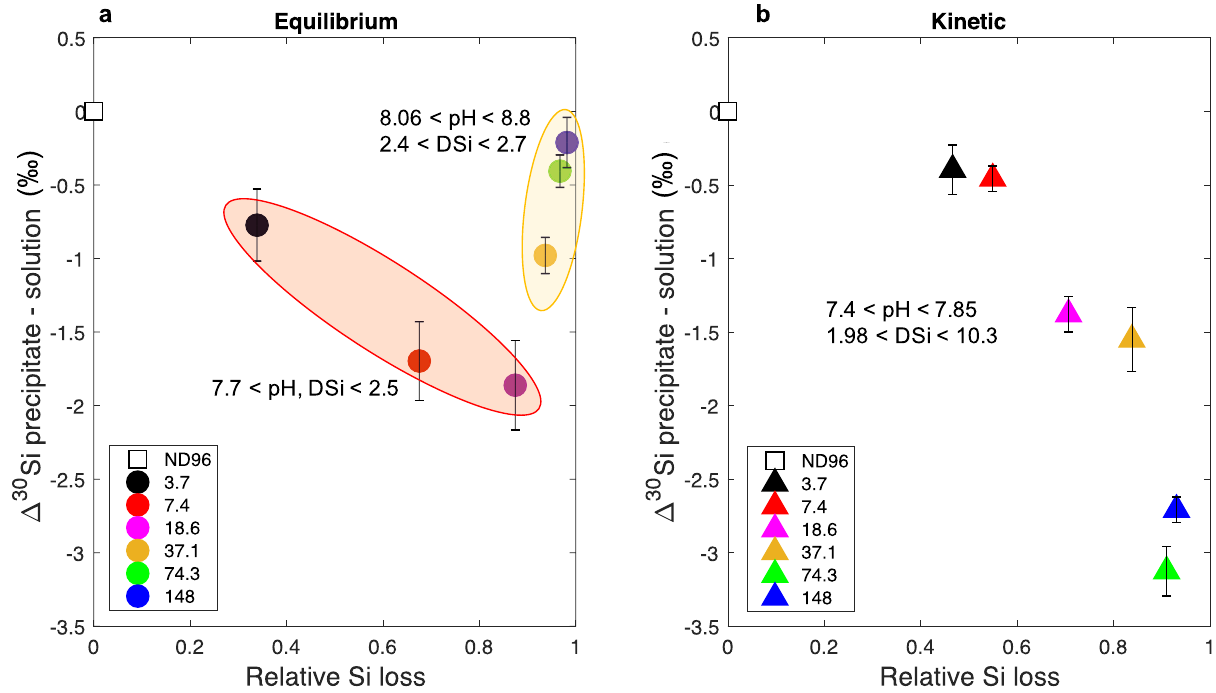
Figure 2. Si isotopic fractionation ( (cid:31) 30 Si p-s ) as a function of the relative silicon loss from solution due to precipitation for a range of dissolved Si concentrations (mM). ( a ) Experiments after 8 days incubation. ( b ) Experiments after 1 h incubation. Each data point represents a different initial starting concentration of Si, coloured according to the key shown in each panel. Shaded areas in each panel group samples by comparable final conditions as shown. Error bars shows the 2 s.d. of the repeated measurements. The starting concentration 371 and 743 mM data are presented in Supplementary Table